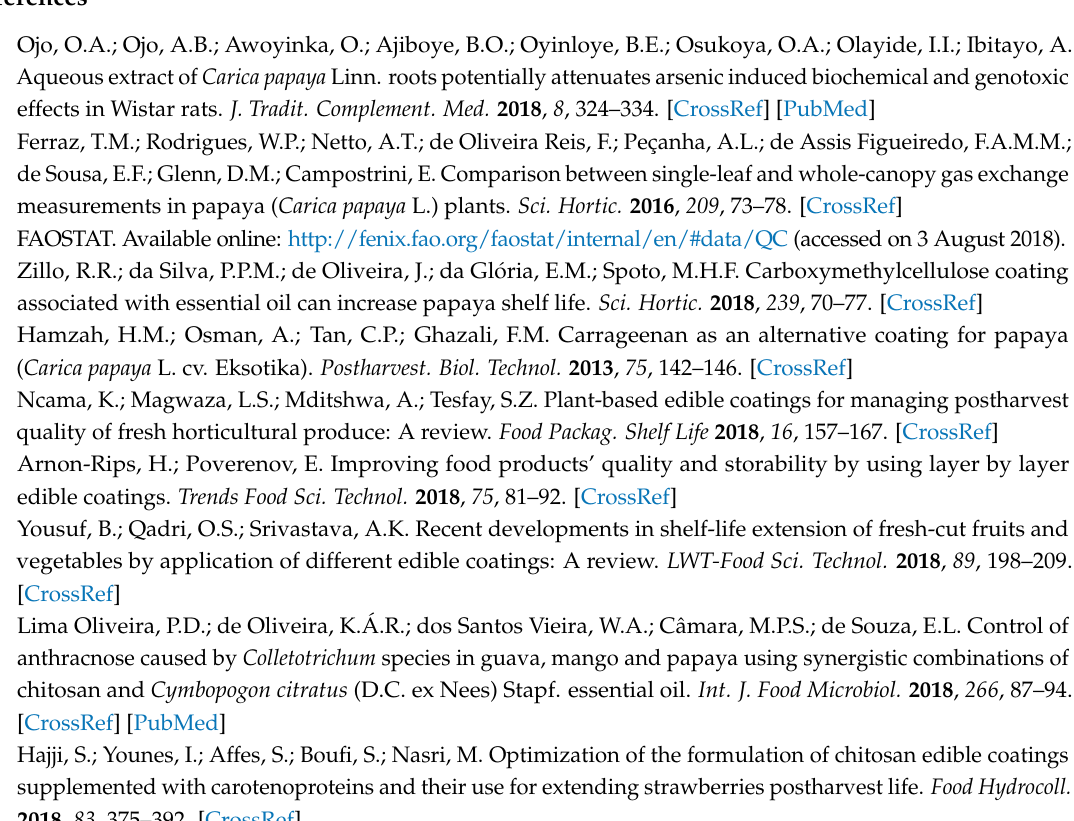
Figure S1: Color development during storage of uncoated papaya, Figure S2: Color development during storage of coated